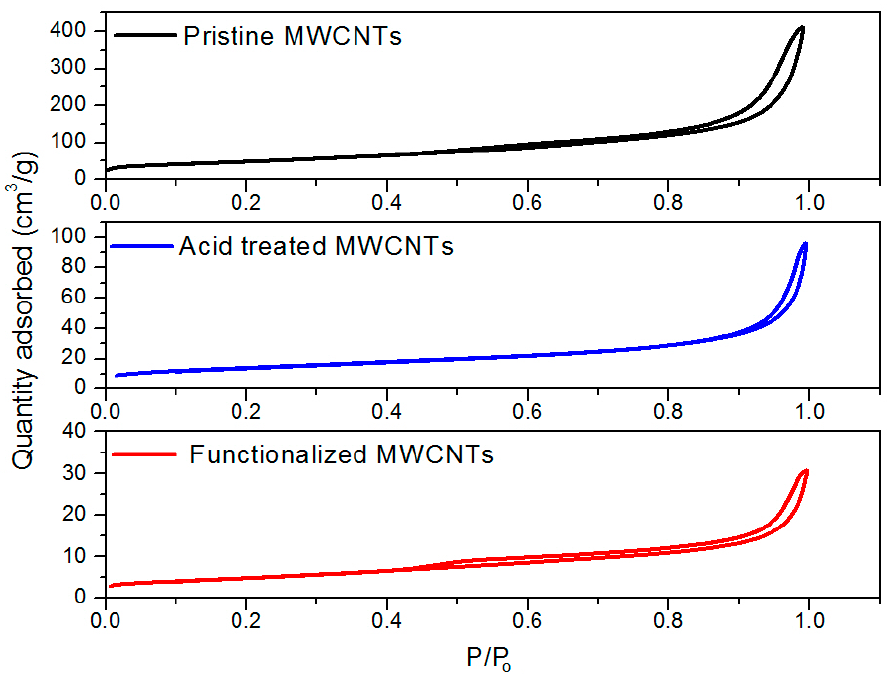
Figure 11. Adsorption / desorption isotherms of pristine and modified MWCNTs.